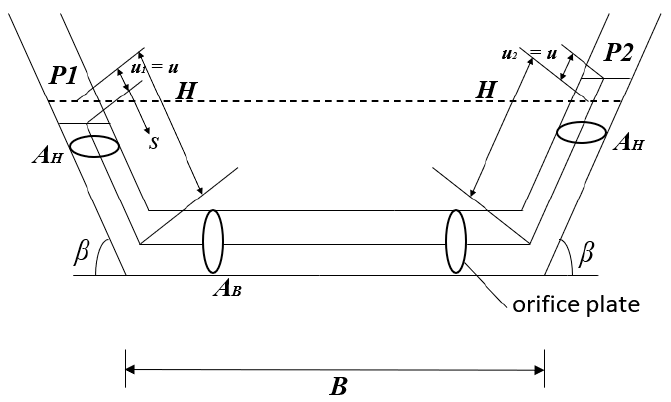
Figure 1. Tuned liquid column damper geometry.